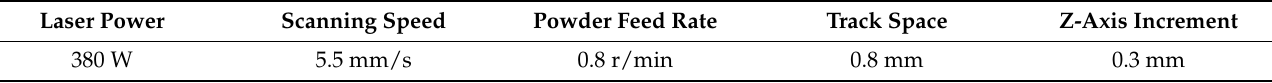
Table 2. Optimal process parameters for four-layer coating by laser